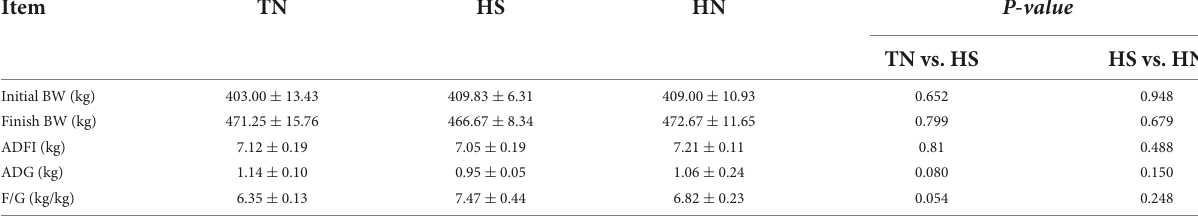
TABLE 4 Effects of dietary niacin on the performance of beef cattle under heat